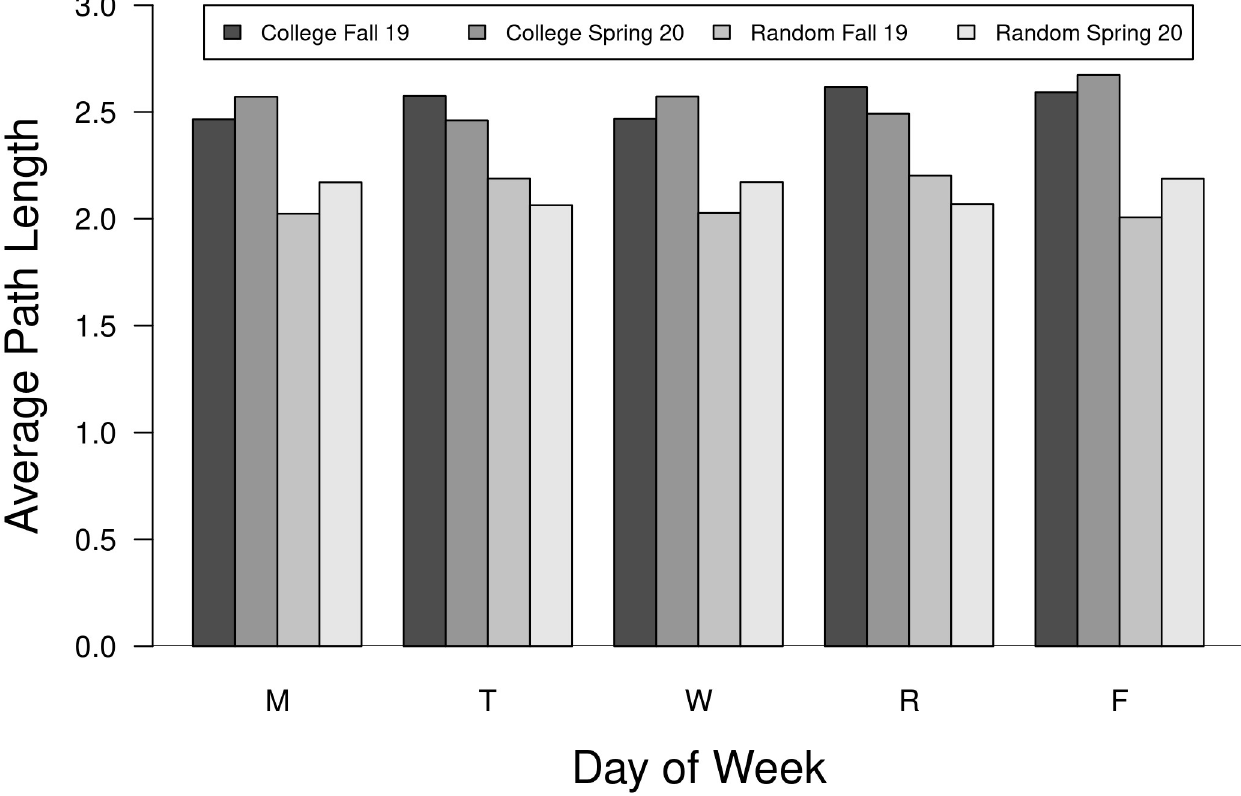
Fig 4. Average path length for college and random networks. The average path length (APL) for weekday networks from the fall 2019 semester are shown. Additionally, APL values for random networks also are shown, which are consistently lower.